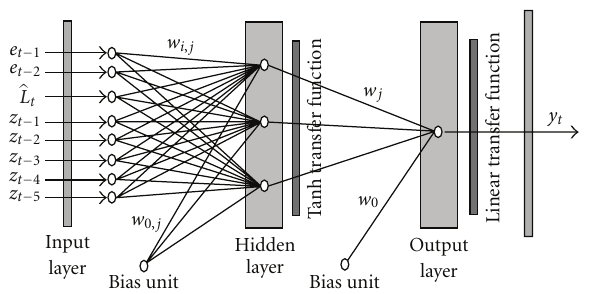
Figure 4: ARIMA model prediction of lynx data (test